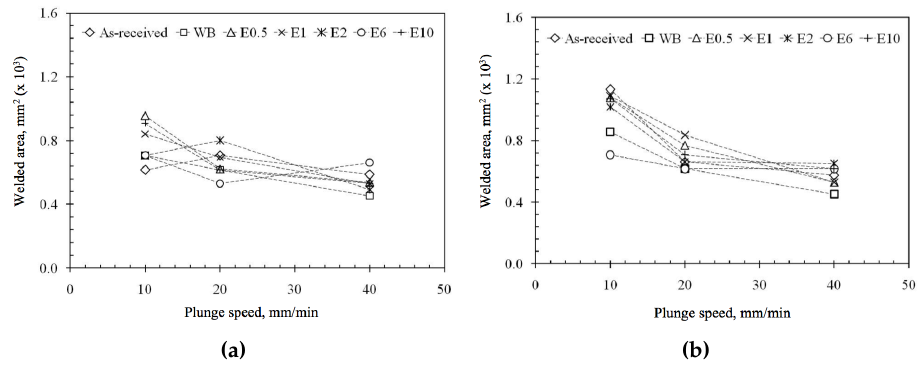
Figure 2. Effect of plunge speed on the welded area for plunge depth ( a ) plunge depth 0.4 mm and ( b ) plunge depth 0.7